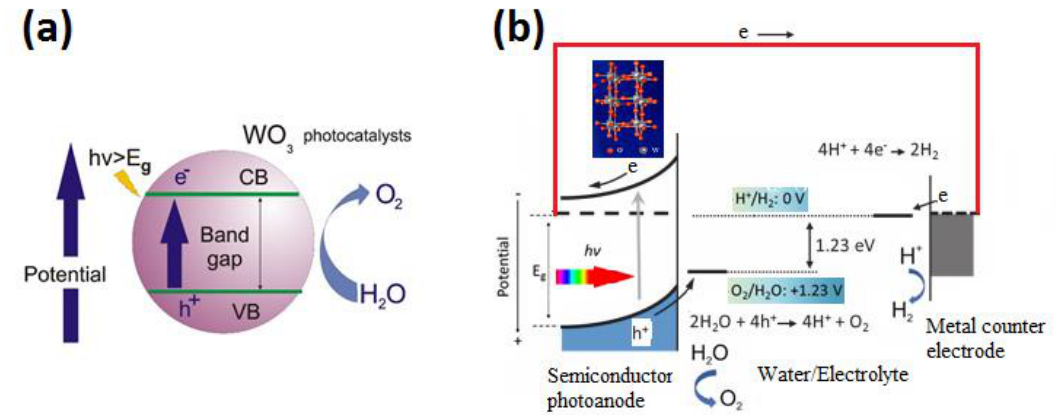
Figure 2. ( a ) Schematic illustration for WO 3 -particle-based photocatalyst system; ( b ) principle of photoelectrochemical